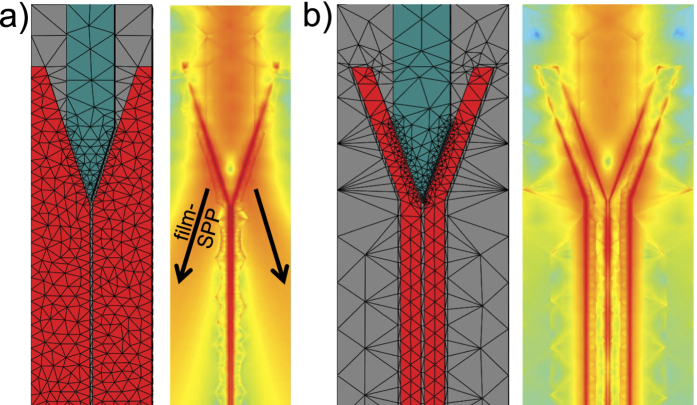
3D FEM meshs and simulated intensity plots of the electric field intensity (logarithmic scale).(a) The transducer with a simple slot-waveguide suffers from parasitic excitation of film modes (indicated by arrows). (b) Two modes excited in the slot-stripe waveguide, leading to a beating effect and - importantly - allowing SPPs to bypass emitters in the slot which undermines the performance of the device.